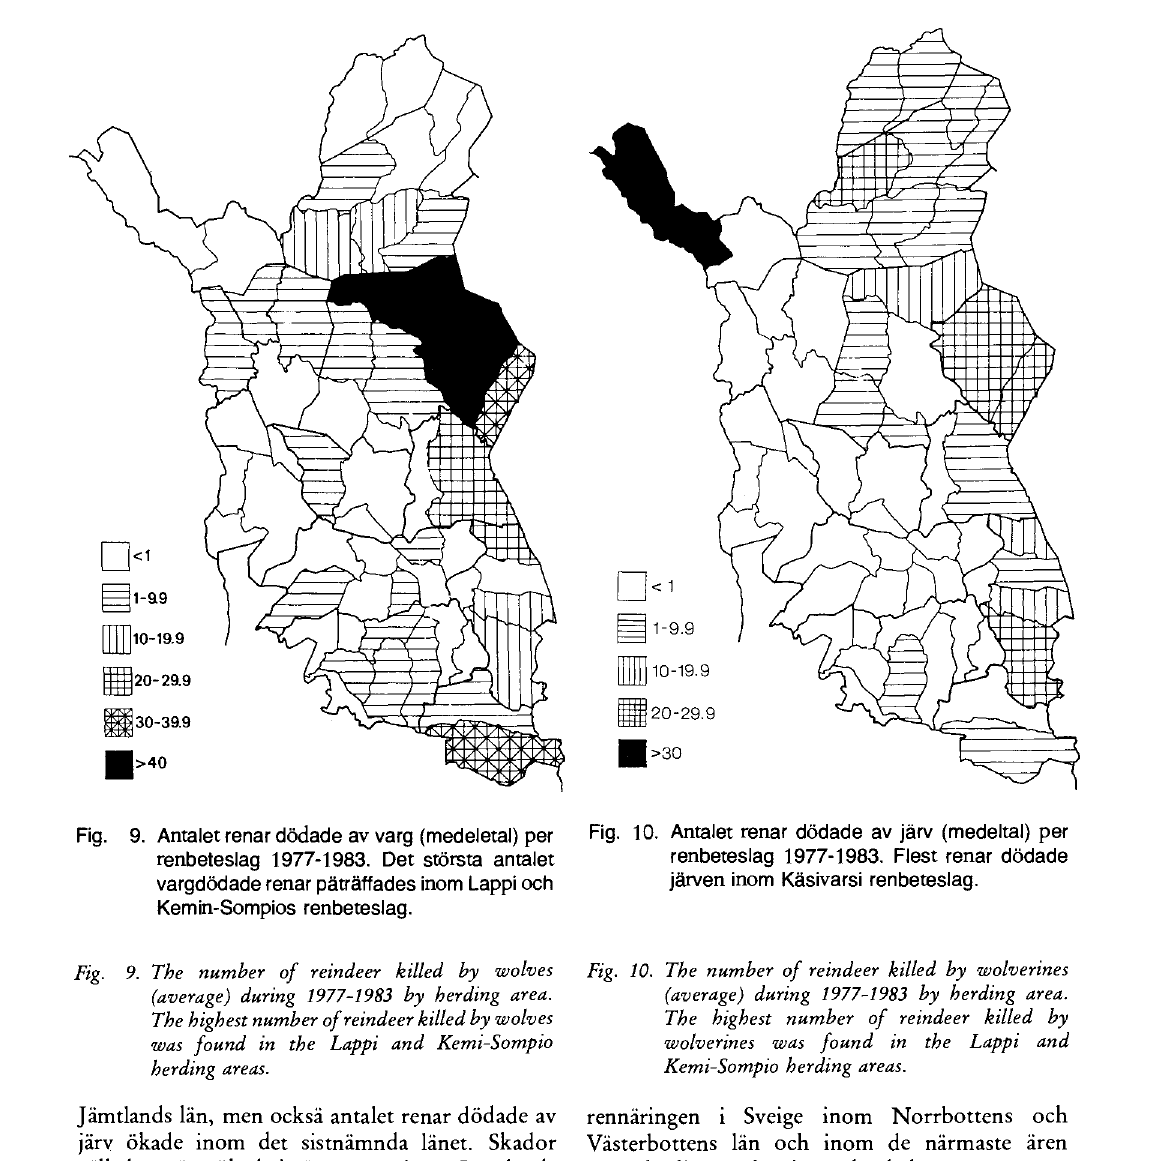
Fig. 10. The number of reindeer killed by wolverines (average) during 1977-1983 by herding area. The highest number of reindeer killed by wolverines was found in the Lappi and Kemi-Sompio herding